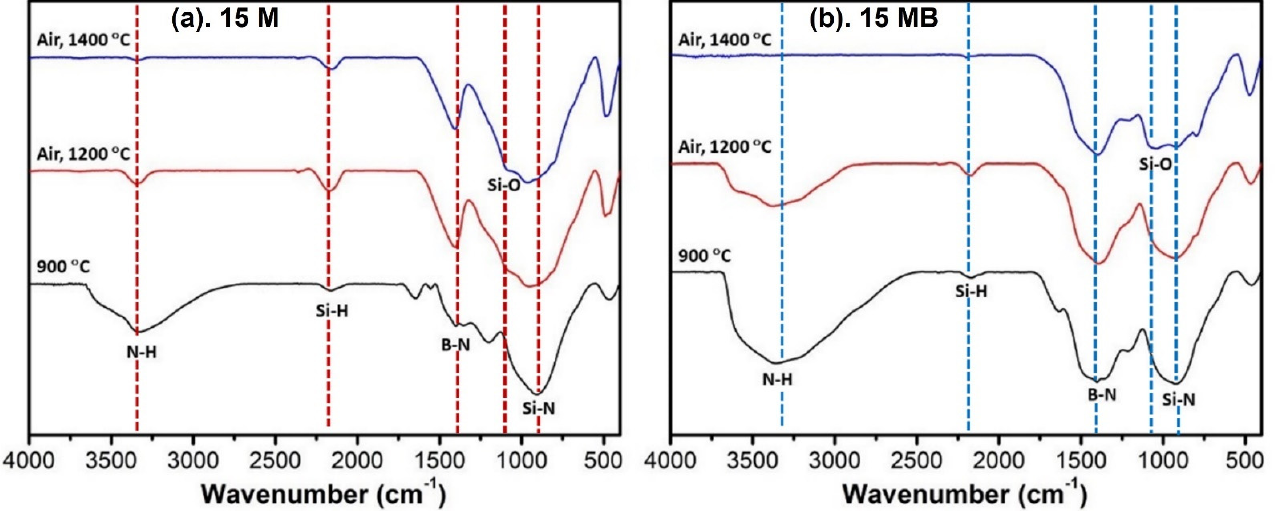
Figure 12. FTIR spectra of the oxidation products of the two precursors ( a ) 15 M and ( b ) 15 MB at different temperatures.